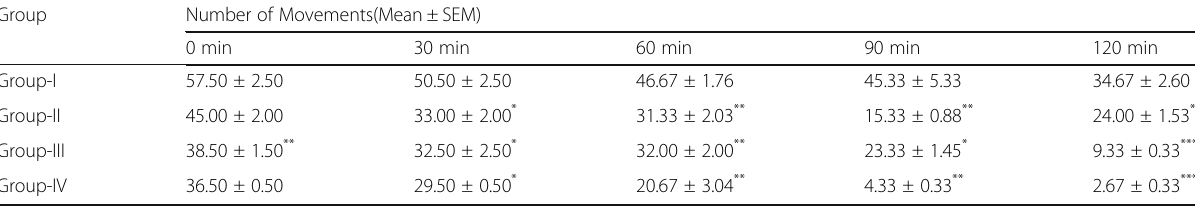
Table 3 Effect of methanolic extract of the L. sativus L. seeds on open field test in mice Group